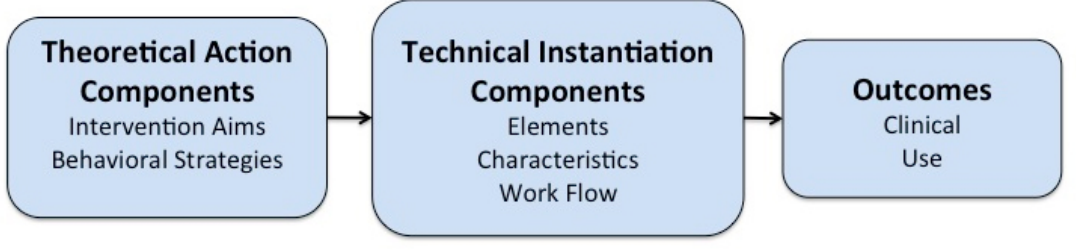
Figure 1. The BIT